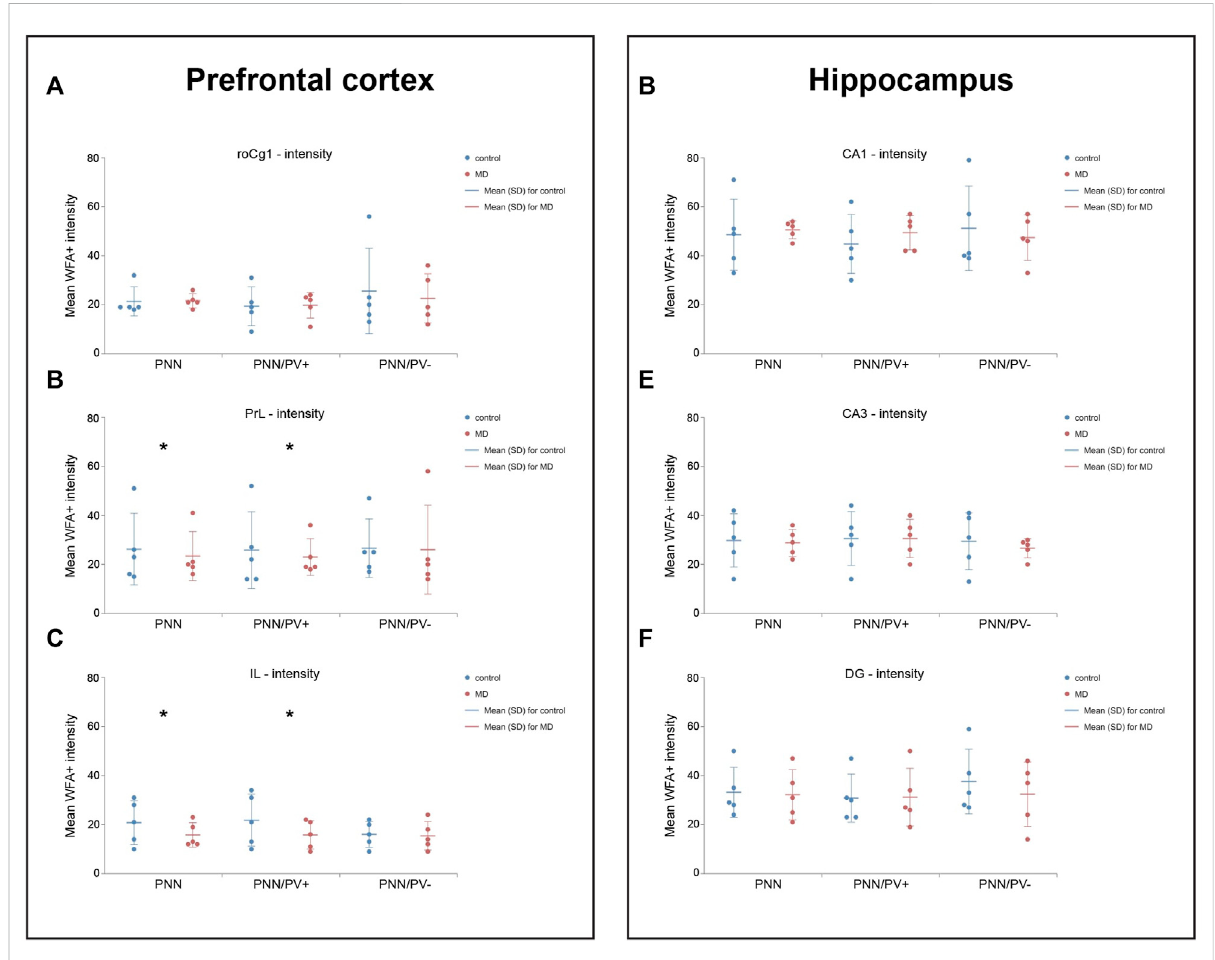
FIGURE 4 EffectsofMDonWFA+perineuronalnetsintensityinthemPFCandhippocampus. Dotplotgraphs representingquanti fi cationsoftheresultsas means ± SD (horizontal bars) and observed values (dots) in the respective mPFC (A – C) or hippocampal areas (D – F) . MD rats had lower intensity of overall PNNs and PNNs surrounding PV + cells in the PrL (B) and IL (C) . *p < 0.001 Control vs. MD. Hippocampal sub fi eld CA1 (CA1) and CA3 (CA3), rostral part of area one of cingulate cortex (roCg1), dentate gyrus (DG), infralimbic cortex (IL), maternally deprived rats (MD), prelimbic cortex